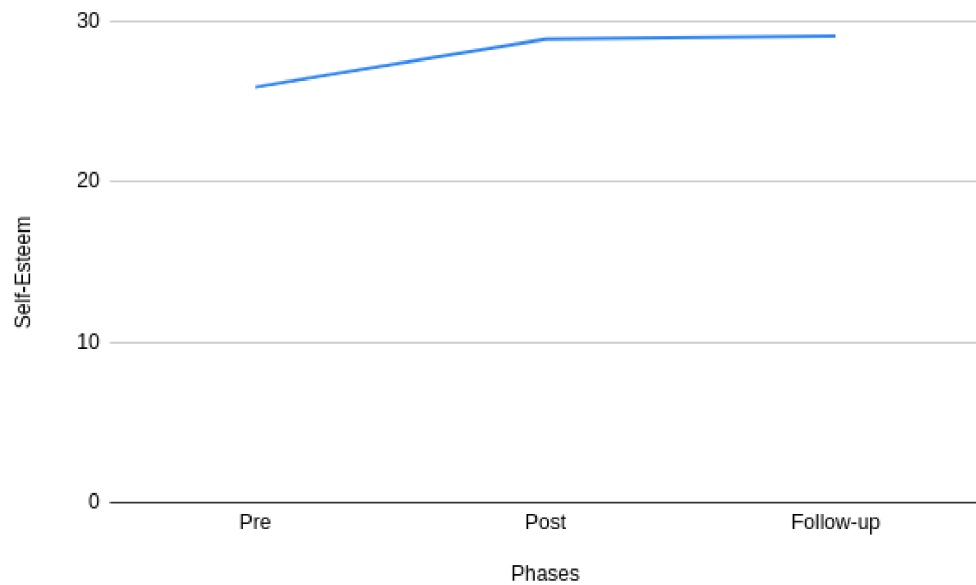
Figure 3. Pre-, post-, and follow-up phases of